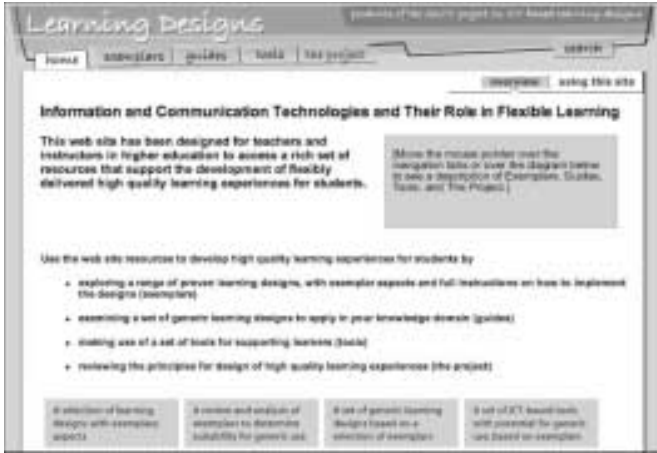
Figure 1. ICTs and their role in flexible learning. A repository of high-quality learning designs for e-learning (http://www.learningdesigns.uow.edu.au) (Australian University Teaching Committee,